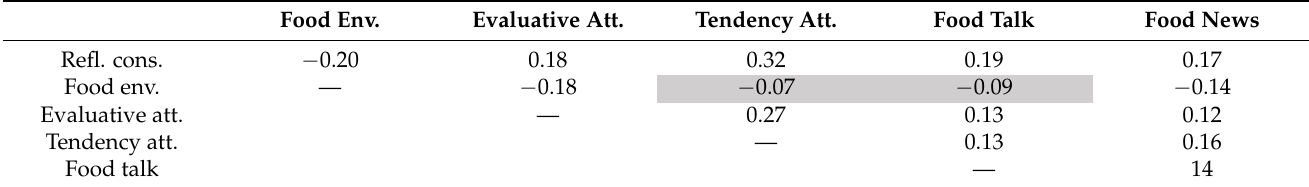
Table 3. Partial Correlations among Model